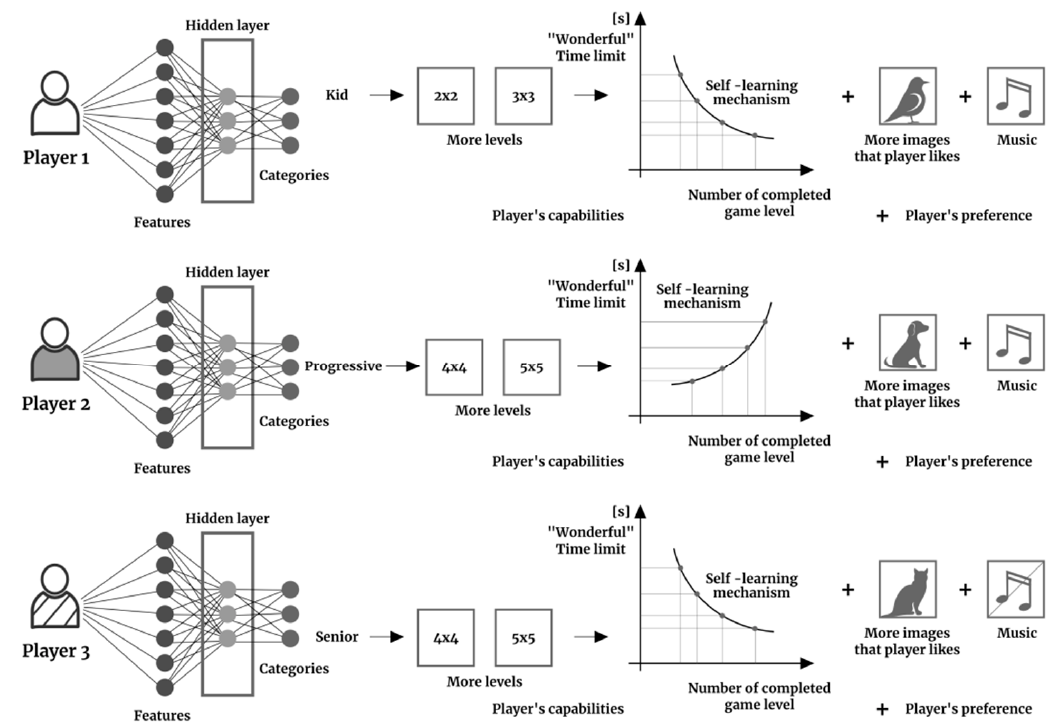
Figure 6. Game adaptation according to player category.